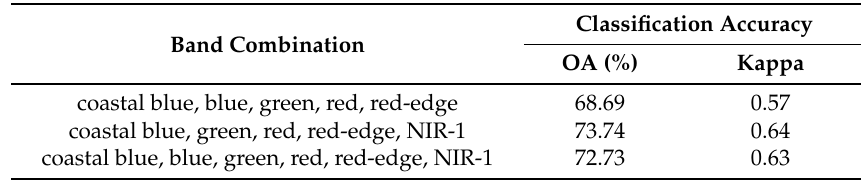
Figure 3. The percentage cover of seagrass map for Paklok Bay derived from Worldview-2 image and field reference data. Table 4. Maximum Likelihood Classification accuracies for mapping percentage seagrass cover using different spectral combinations. OA is the Overall